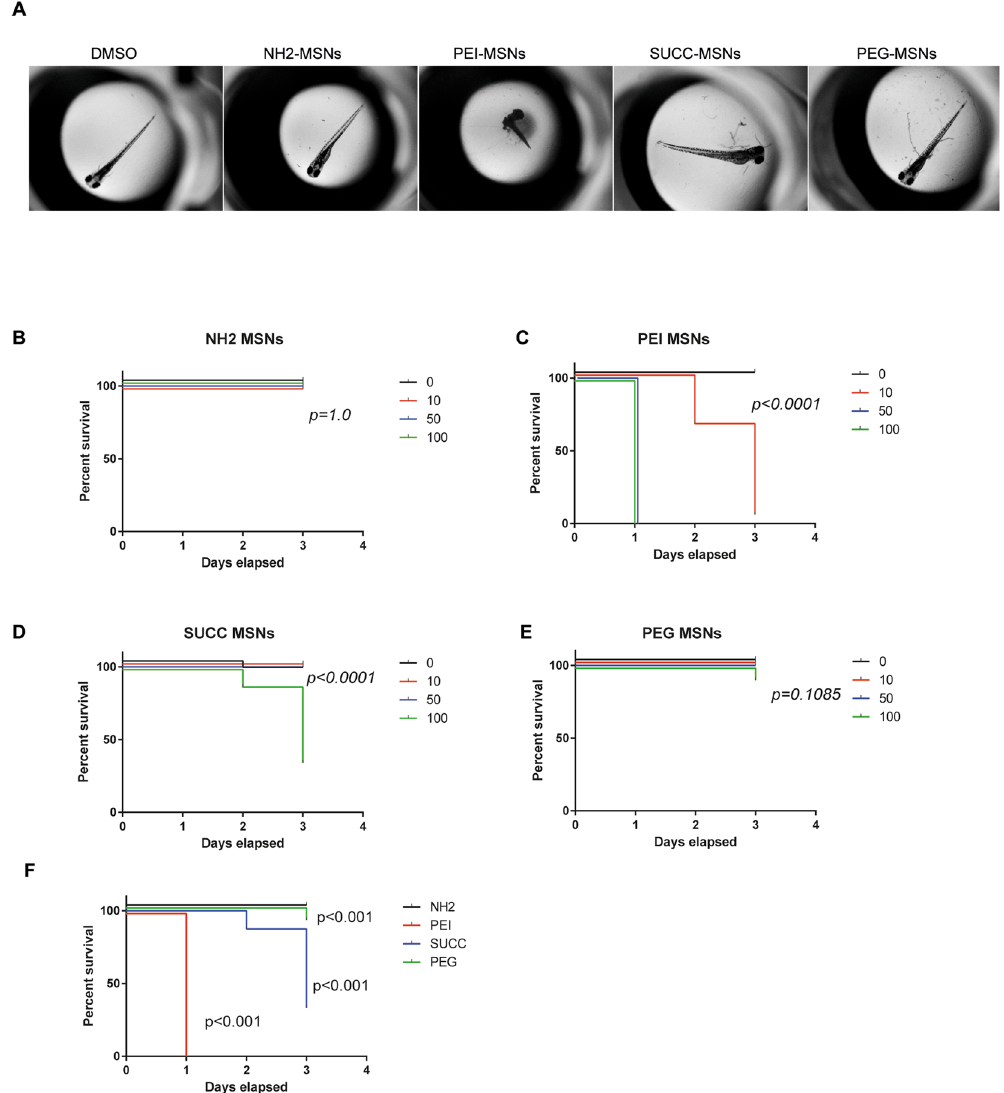
( B – E ) Percentage of survival of dechorionated embryos at 48 hpf, 72hpf and 96 hpf upon treatment with ( B ) NH2, ( C ) PEI, ( D ) SUCC and ( E ) PEG MSNs at denoted concentrations. The treatment was initated at 24hpf. N = 24 embryos/treatment, except in PEI-MSN 0 μ g/ml (n = 25), SUCC-MSN 0 μ g/ml (n = 23), SUCC-MSN 10 μ g/ml (n = 23) and SUCC-MSN 100 μ g/ml (n = 25). Each embryo was followed throughout the experiment and score live or dead on each day ( F ) Comparison of survival between MSNs at 100 μ g/ml